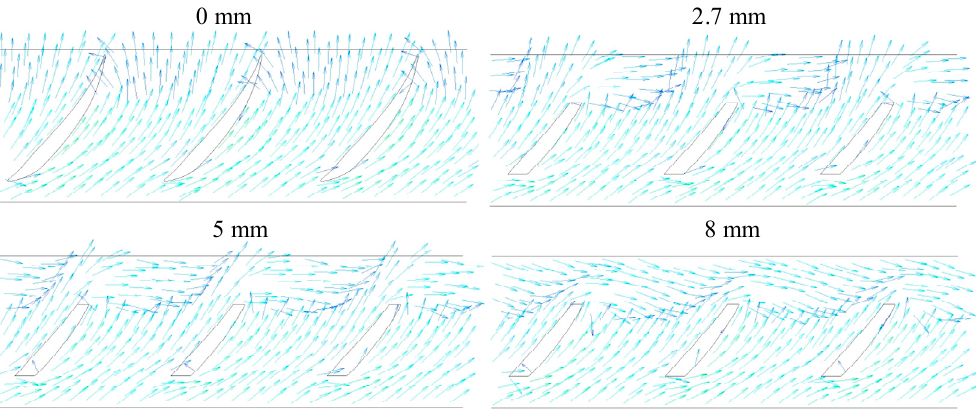
8 mm0 mm Figure 12. Velocity contour at Span = 0.015 in impeller passage with varying root clearances ( R t = 0 mm, 2.7 mm, 5 mm 8 mm; Q = 1.0 Q des ).